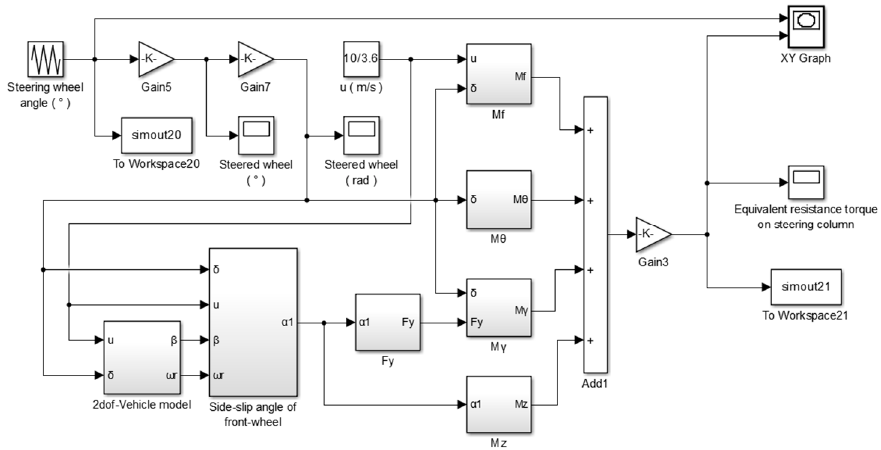
Figure 8. Simulation model of the low-speed steering resistance torque.